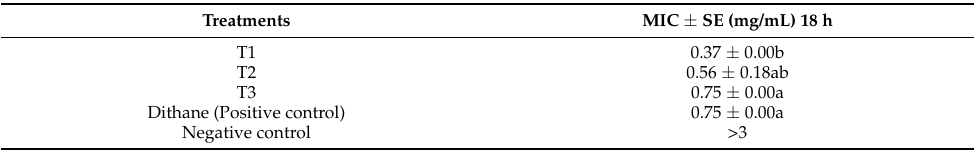
Table 7. Anti- F. oxysporum activity (mean MIC ± SE) of ethanol extracts of H. odorattisimum plants that were cultivated in aquaponic, hydroponic, and field